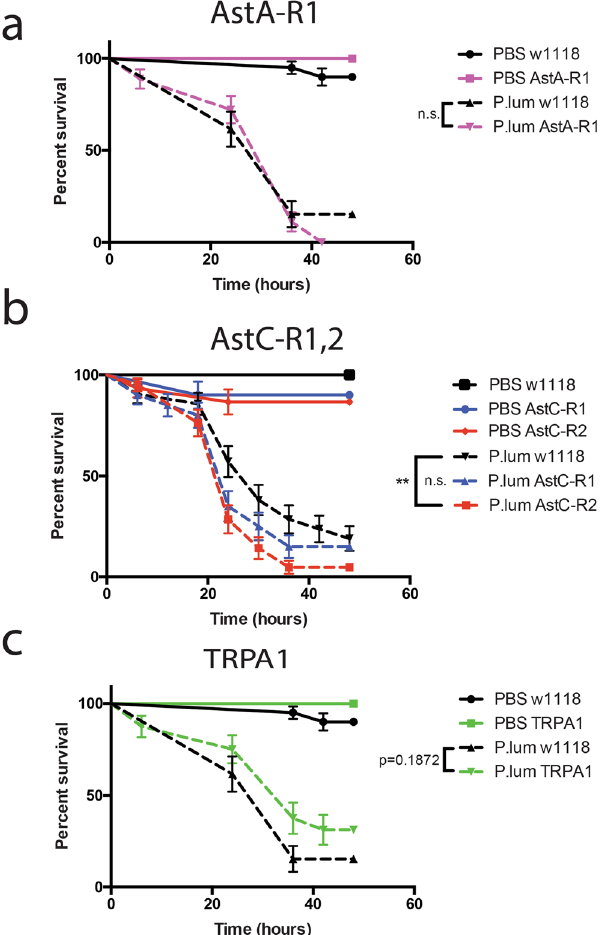
Figure 4. Allatostatin-C Receptor Drosophila mutants show increased susceptibility to P . luminescens infection. Survival curves of RNAi mutant flies for ( a ) AstA-R1 ( b ) AstC-R1 and AstC-R2 and ( c ) TRPA1 post injection with PBS, P . luminescens , and E . coli . Although neither AstA-R1 and TRPA1 RNAi mutants displayed a reduced survival during P . luminescens infection, AstC-R1 and AstC-R2 RNAi flies succumbed faster than their controls with AstC-R2 RNAi individuals showing significantly increased sensitivity to the pathogen (p < 0.01). RNAi mutants were generated by crossing UAS-RNAi lines with an Actin5c Gal4 driver in order to knock the gene of interest down ubiquitously. Survival curves were analyzed using survival curve analysis in GraphPad Prism software (n = 3 groups of 20 flies, ** p <